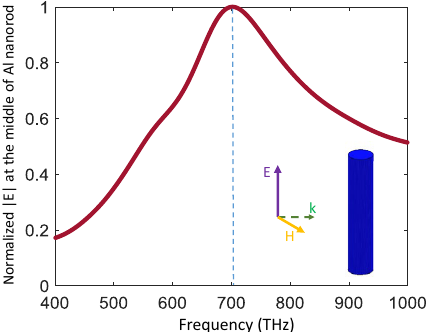
Figure 1. Electric field intensity at the center of a 100 nm long Al rod with 20 nm diameter, illuminated by a linearly polarized plane